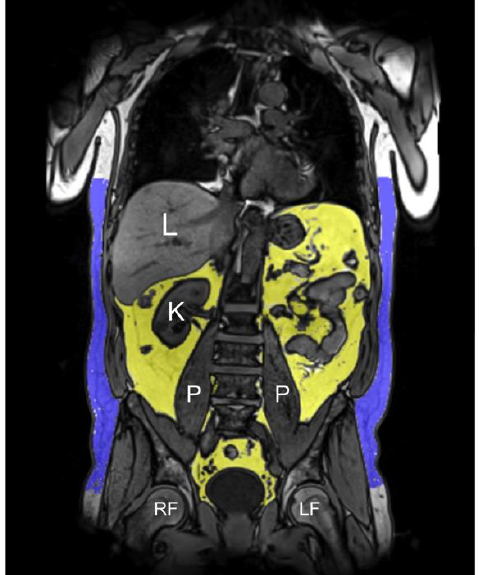
Figure 1. Representative example of the semi-automatic MRI-based assessment of fat depots in a 60-years-old male on reconstructed 3D VIBE-Dixon images (VAT 5.3 L, SAT 7.7 L, TAT 13.0 L). Visceral adipose tissue (VAT, yellow area) and subcutaneous adipose tissue (SAT, blue area) were measured from the diaphragm/cardiac apex to the femoral head; total adipose tissue (TAT) was defined as the sum of VAT and SAT, indicated in liter. L = liver, K = kidney, P = psoas muscle, RF = right femoral head, LF = left femoral head.